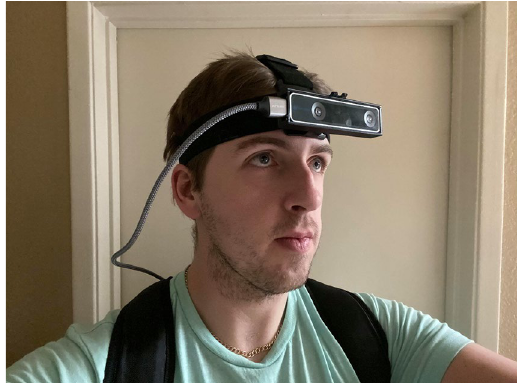
Figure 1. Recording equipment. The T265 measures 6 degree of freedom (6DOF) position of the camera relative to the world, and is worn on the head by a participant over 5 h. The camera plugs into a lightweight laptop worn in a